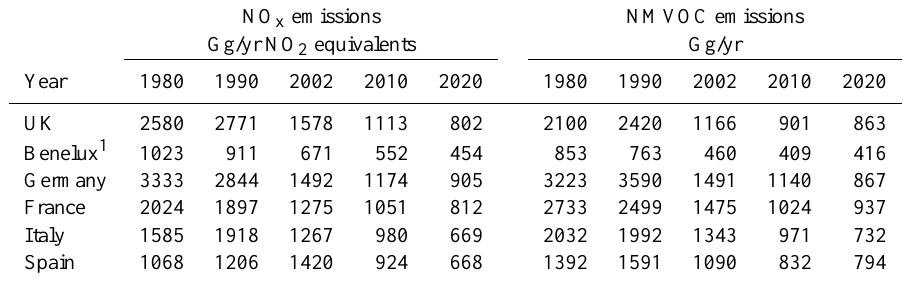
Table 5. NO x and VOC emissions and emission projections for selected countries from http://webdab.emep.int (Vestreng,